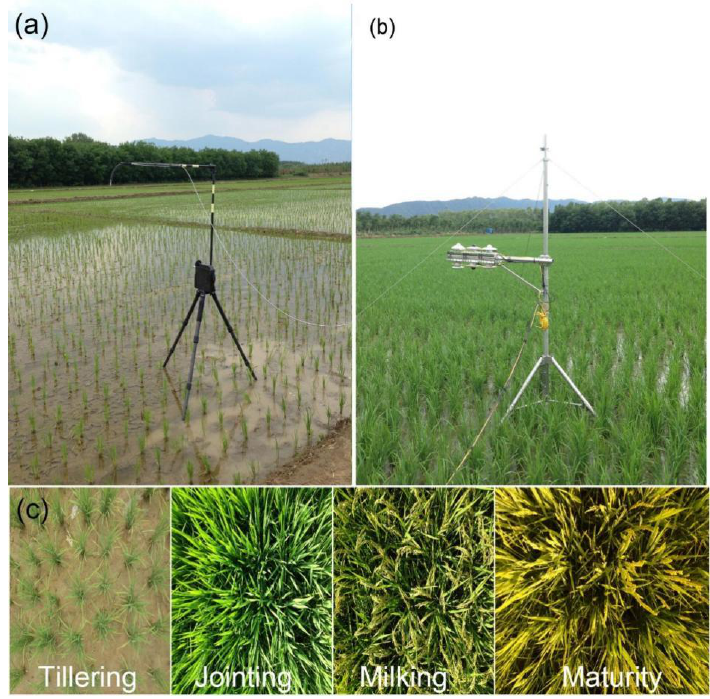
Figure 1. Instruments of directional reflectance measurement ( a ) and surface albedo observation ( b ); growing stages of paddy rice ( c ).